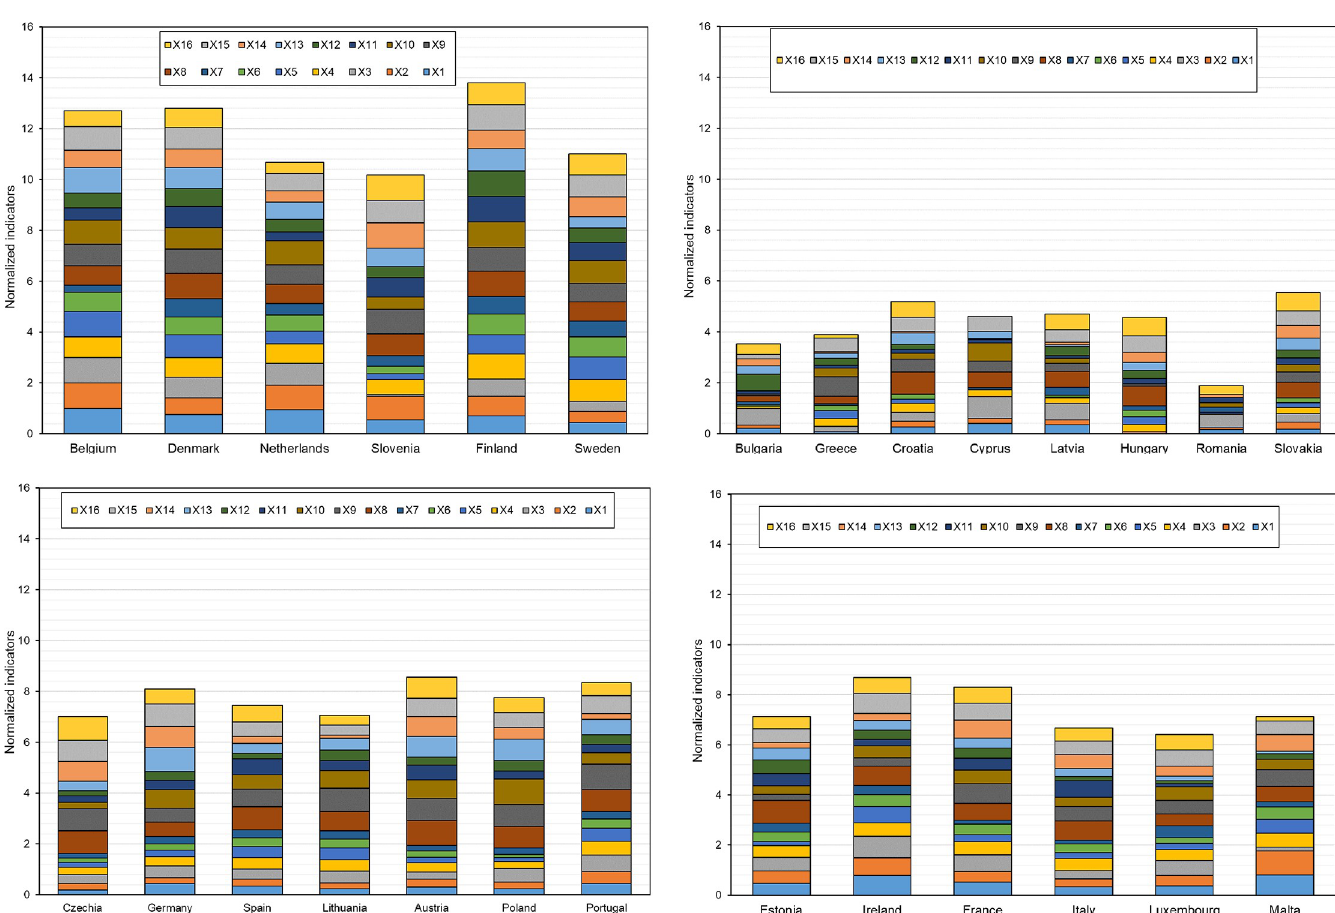
Fig 6. The summary of studied indicators on digitalization and robotization of enterprises for the EU countries in the designated similar groups (a-cluster 1, b-cluster 2, c-cluster 3, d-cluster 4).